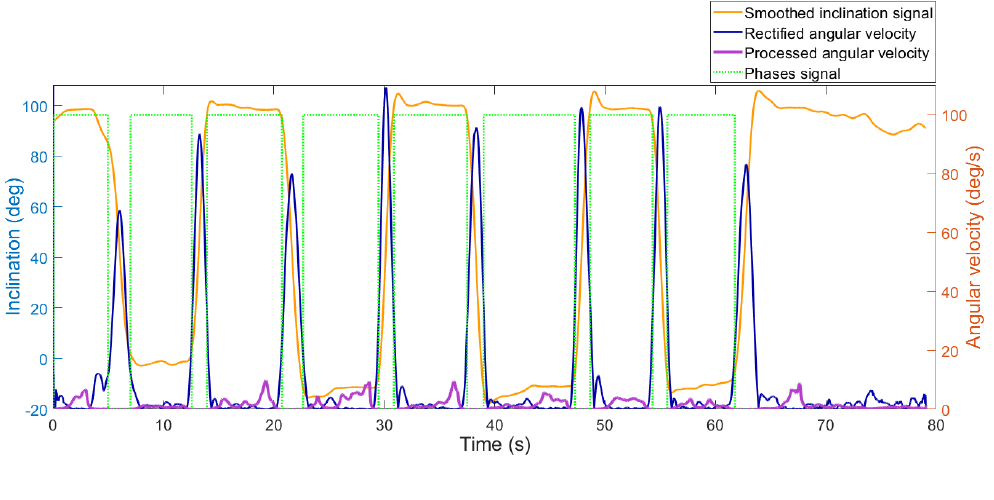
Figure 4. Signal processing of the inclination signal in order to obtain the “phases signal” which automatically defines the phases and cycles during a flexion-relaxation